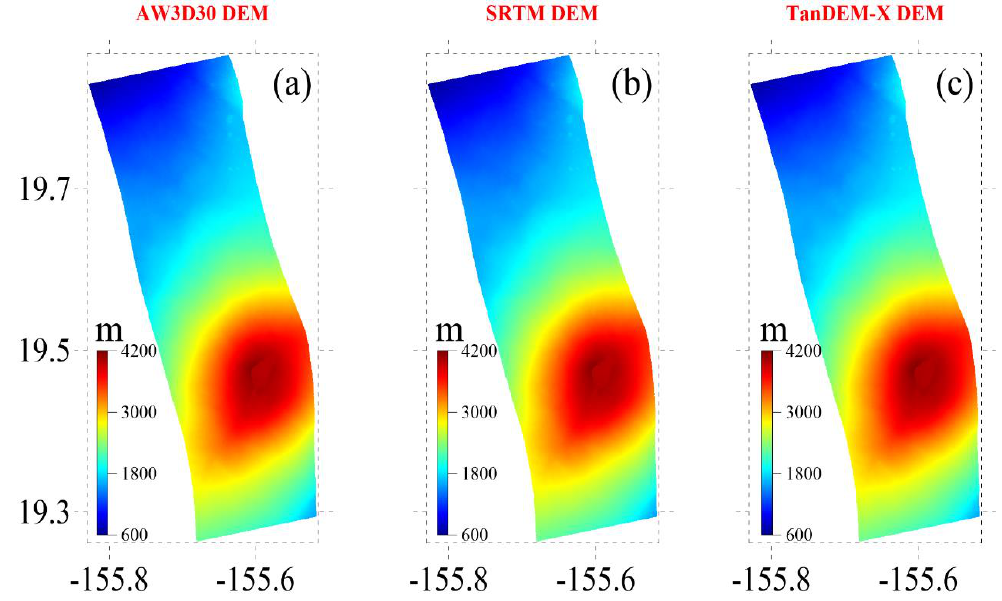
Figure 3. The DEM data used in this study. ( a ) AW3D30 DEM, ( b ) SRTM DEM and ( c ) TanDEM-X DEM.